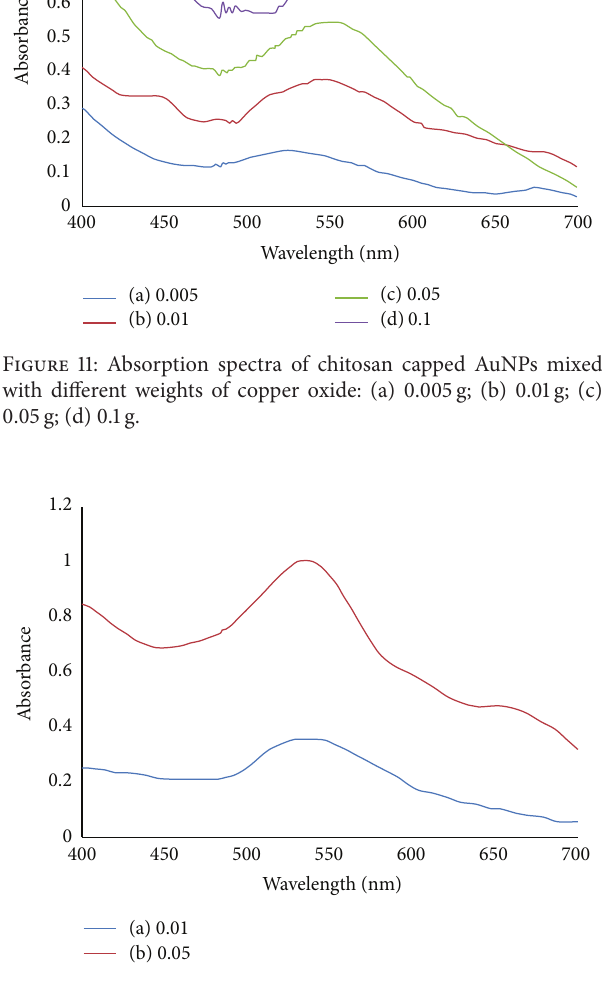
Figure 12: Absorption spectra of chitosan capped AuNPs mixed at different weights of zinc sulphate (a) 0.01 g; (b) 0.05